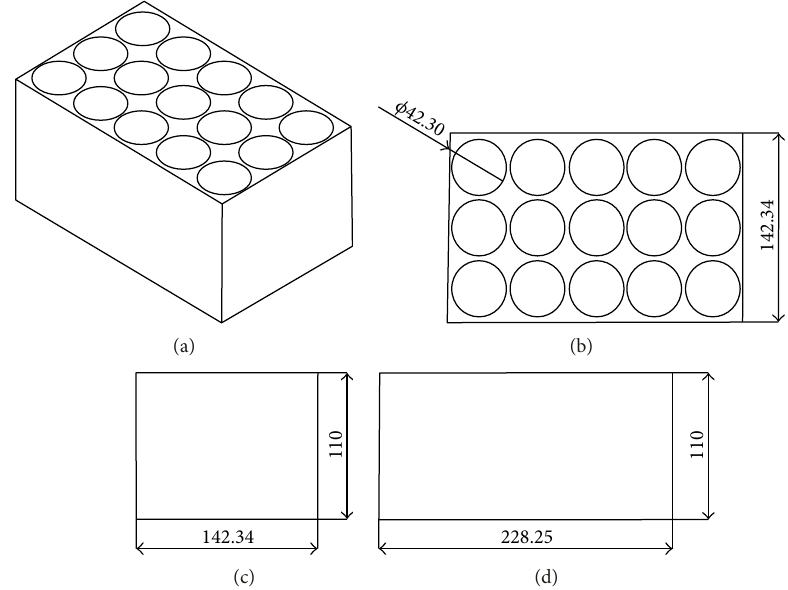
Figure 1: The battery module sizes with PCM. (a) The whole structure: (b) top view, (c) left view, and (d) front